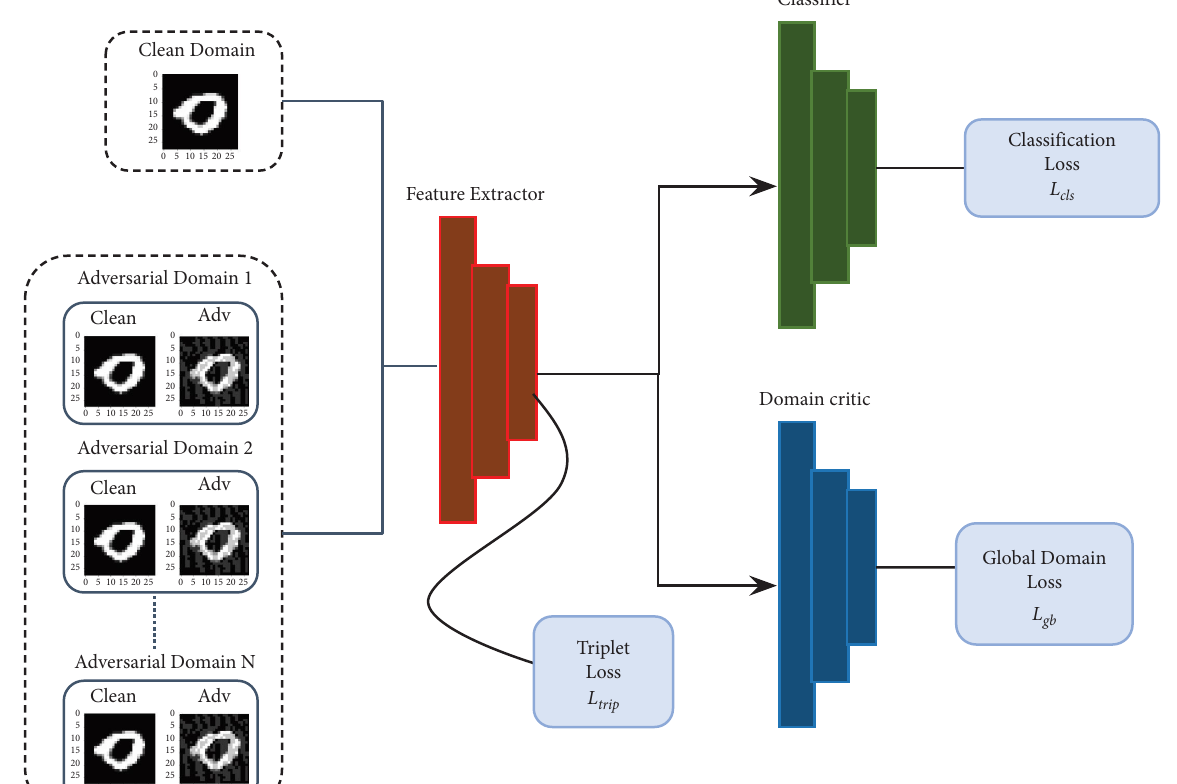
Figure 1: 'e architecture of the proposed